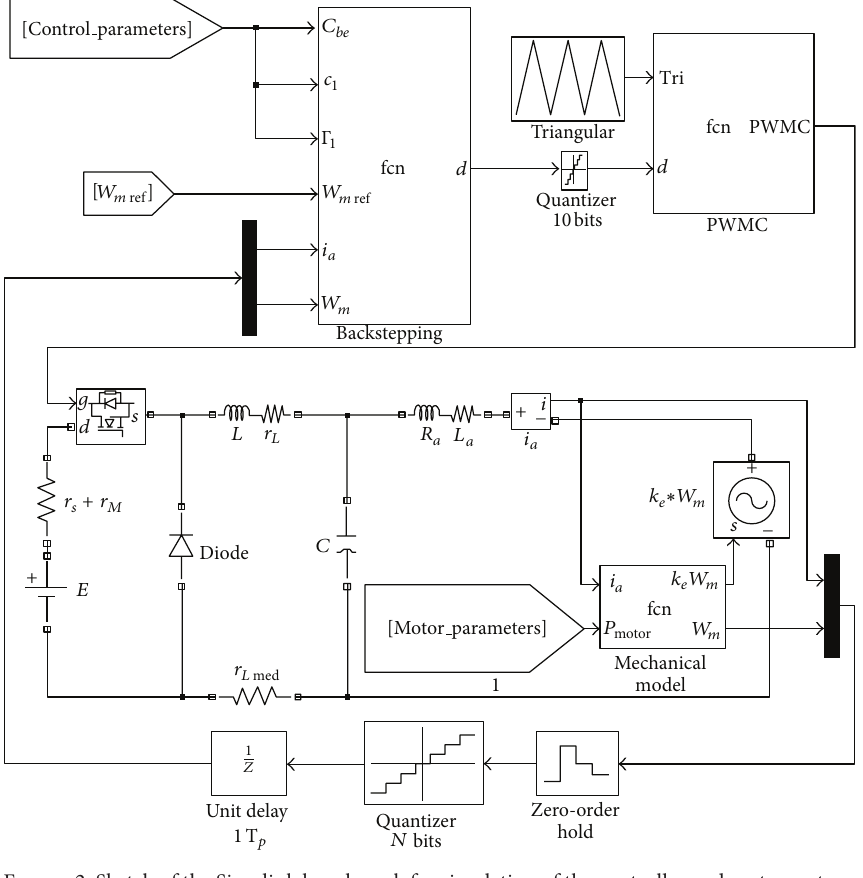
Figure 2: Sketch of the Simulink benchmark for simulation of the controller and motor system.